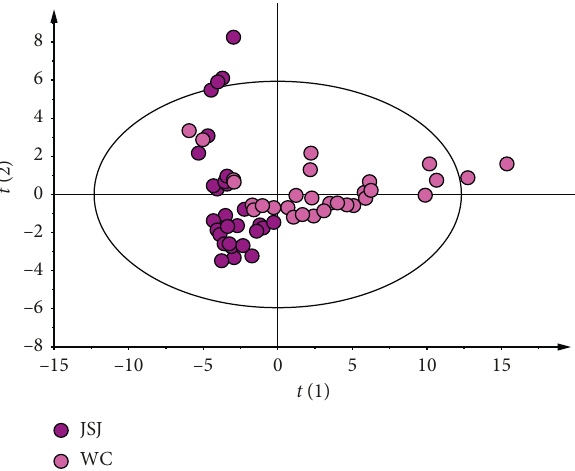
Figure 3: PLS-DA score plot of samples in two origins.